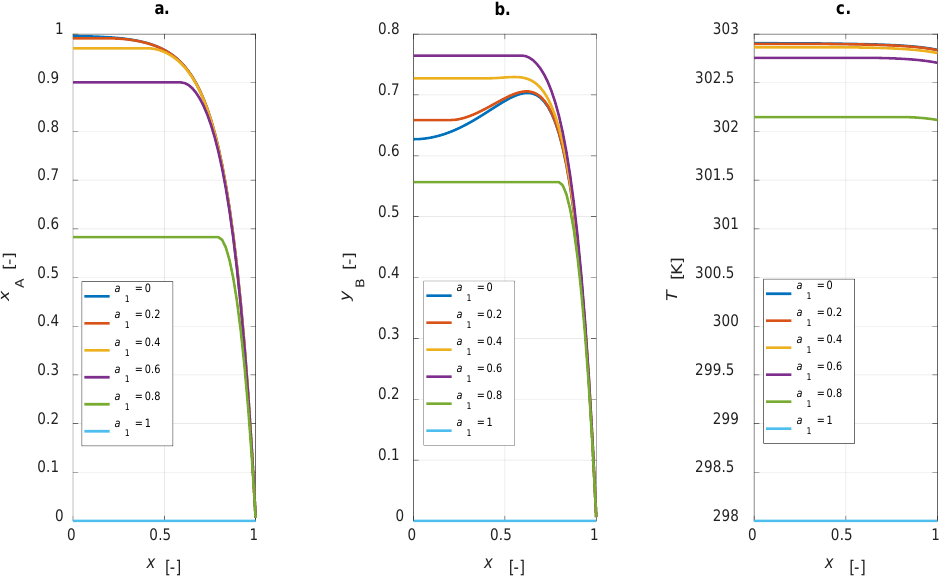
Figure 4. Intraparticle profiles calculated for the egg-shell catalyst varying the active phase content: ( a ) A conversion; ( b ) yield to B; ( c ) temperature.